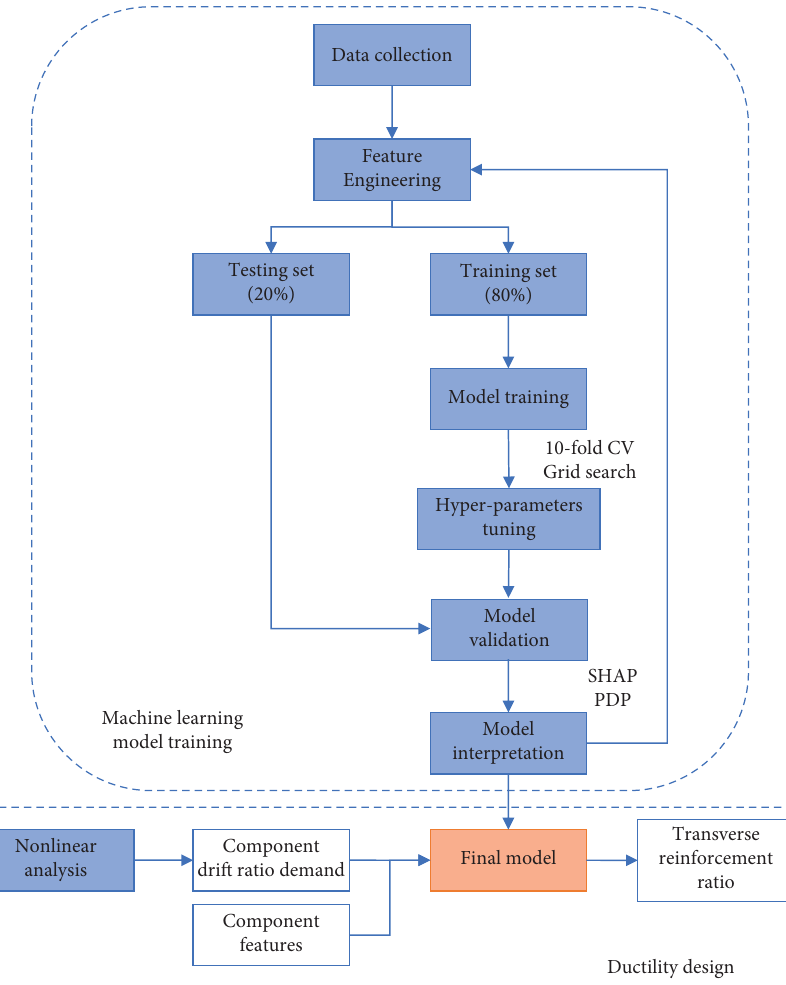
Figure 1: Flow chart of ductility design method based on ML